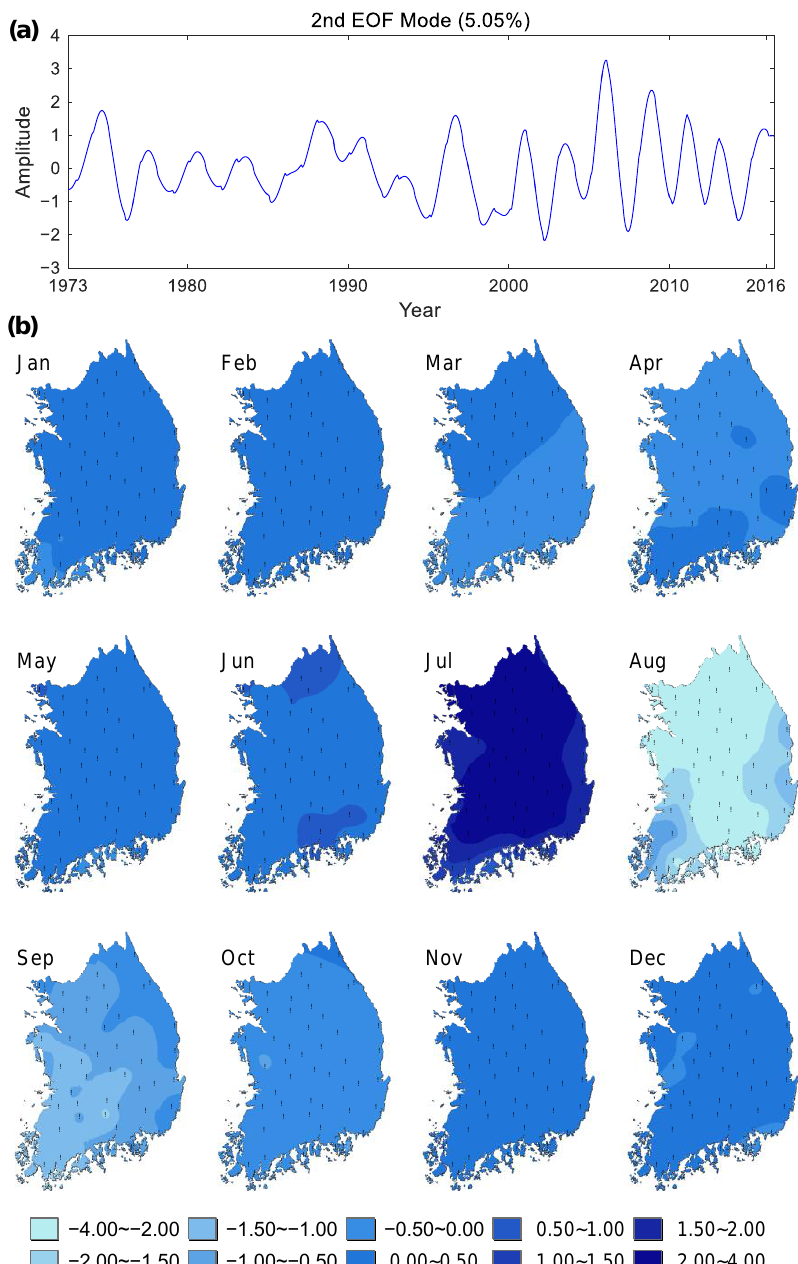
Figure 8. Second CSEOF modes of precipitation: ( a ) principal component time series, ( b ) cyclosta- tionary loading vectors (CSLV). In the EOF and CSEOF analyses, the thirteen leading EOF modes and fifteen leading CSEOF modes account for 95.15% and 95.22% of the total variance, respectively; these modes are statistically significant and distinct from the other modes; thus, they are se- lected for forecasting according to the rule of thumb [41]. The 13 leading temporal modes from the EOF and 15 modes form the CSEOF can account above 95% of total variance are interpreted as the primary conditions for the formation of precipitation, with the remain- ing modes considered as noise of data.